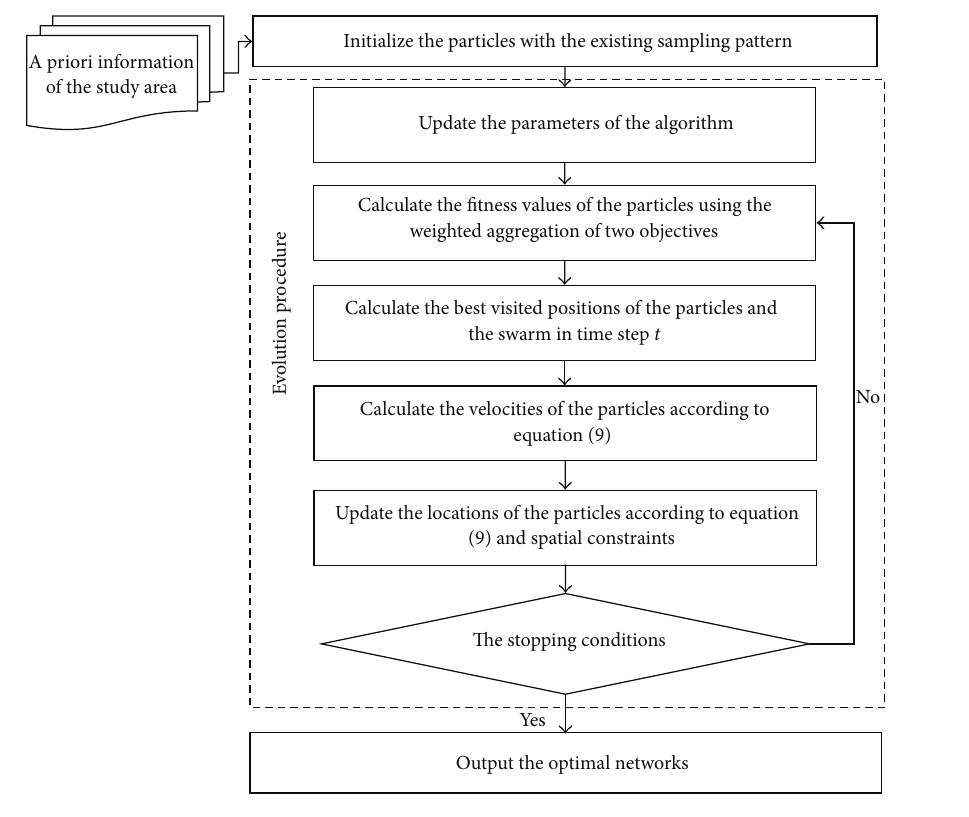
Figure 2: Flow chart of the modified particle swarm optimization algorithm.